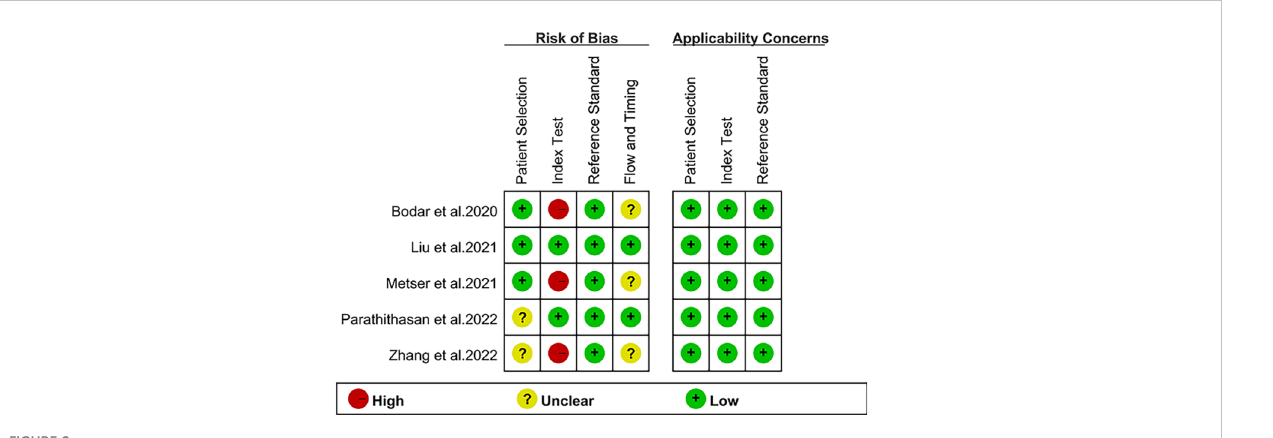
FIGURE 2 Study risk of bias and applicability concerns